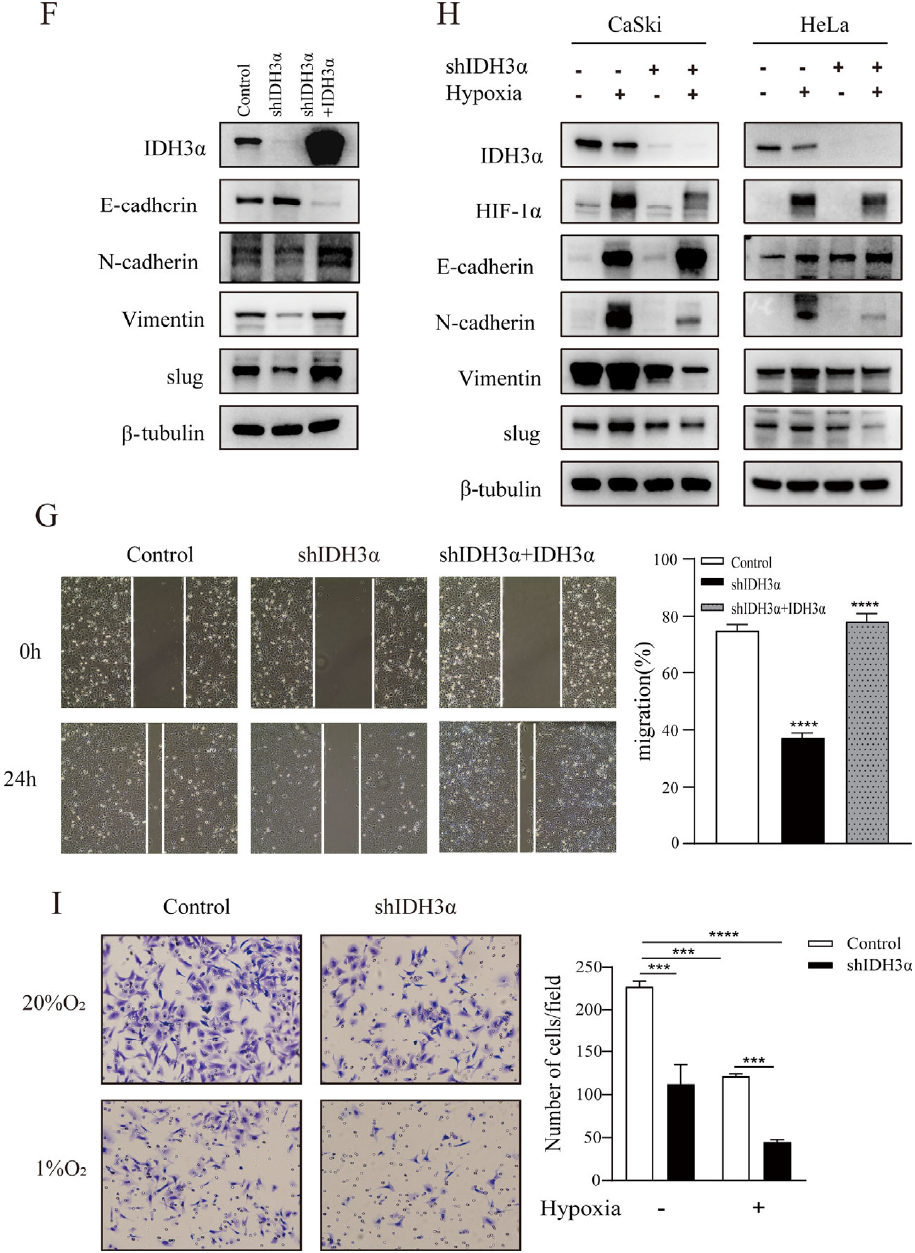
Figure 3. IDH3 α knockdown inhibited the EMT and disrupted EMT ‐ related biomarkers in UCC cells. ( A ) Morphological changes in CaSki and HeLa cells were observed under a phase contrast microscope. ( B , C ) qPCR ( B ) and WB ( C ) were used to detect E ‐ cadherin, N ‐ cadherin, vimentin, and slug in UCC cells. ( D ) Scratch assay and histogram statistics (right) show that the downregulation of IDH3 α inhibited CaSki and HeLa cell migration ability. ( E ) Transwell cell invasion assays and histogram statistics (right) used for HeLa ‐ shIDH3 α and control cells. ( F ) WB was used to detect EMT ‐ related marker expression after knocking down IDH3 α expression and re ‐ expressing it in CaSki cells. ( G ) The scratch assay was used to detect cell migration ability after knocking down IDH3 α expression and re ‐ expressing it in CaSki cells. ( H ) Expression of EMT ‐ related markers under hypoxia was detected by using WB. ( I ) The invasion ability of cervical cancer cells detected by the transwell assay under hypoxia. Data are shown as mean ± SD. *** p < 0.001 and **** p < 0.0001.